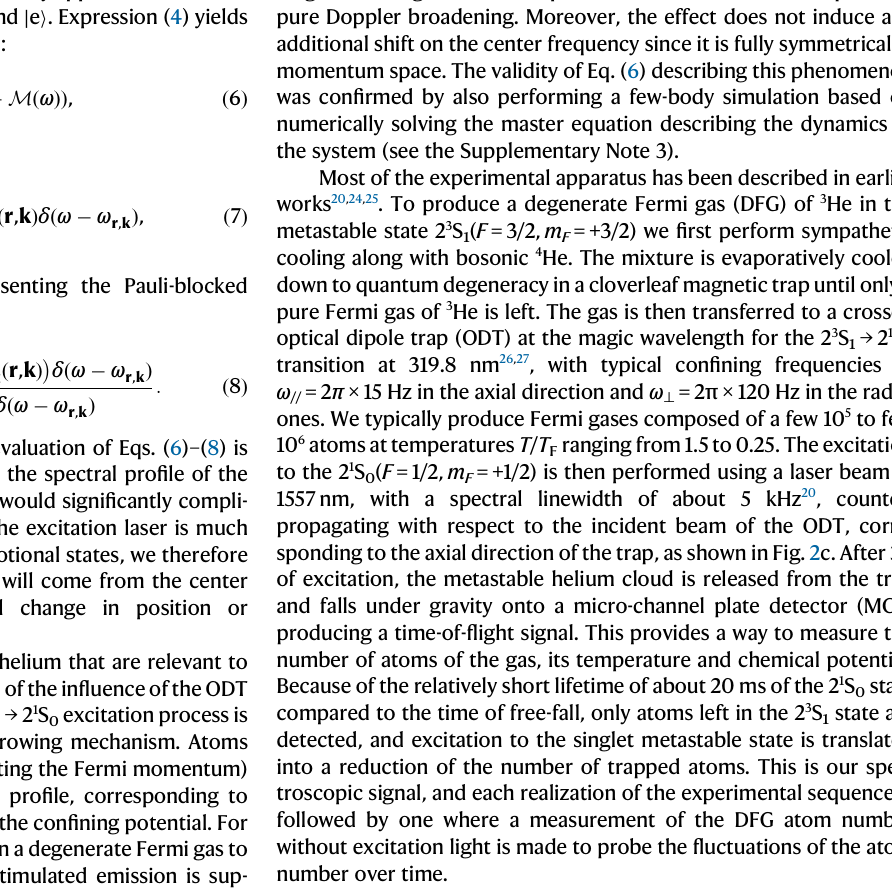
energy states. This results in a narrowing of the spectrum. c Schematic of the experiment. The Fermi gas is trapped in a crossed dipole trap at 320 nm. The spectroscopybeamat1557nmcounterpropagateswithrespecttooneofthebeams